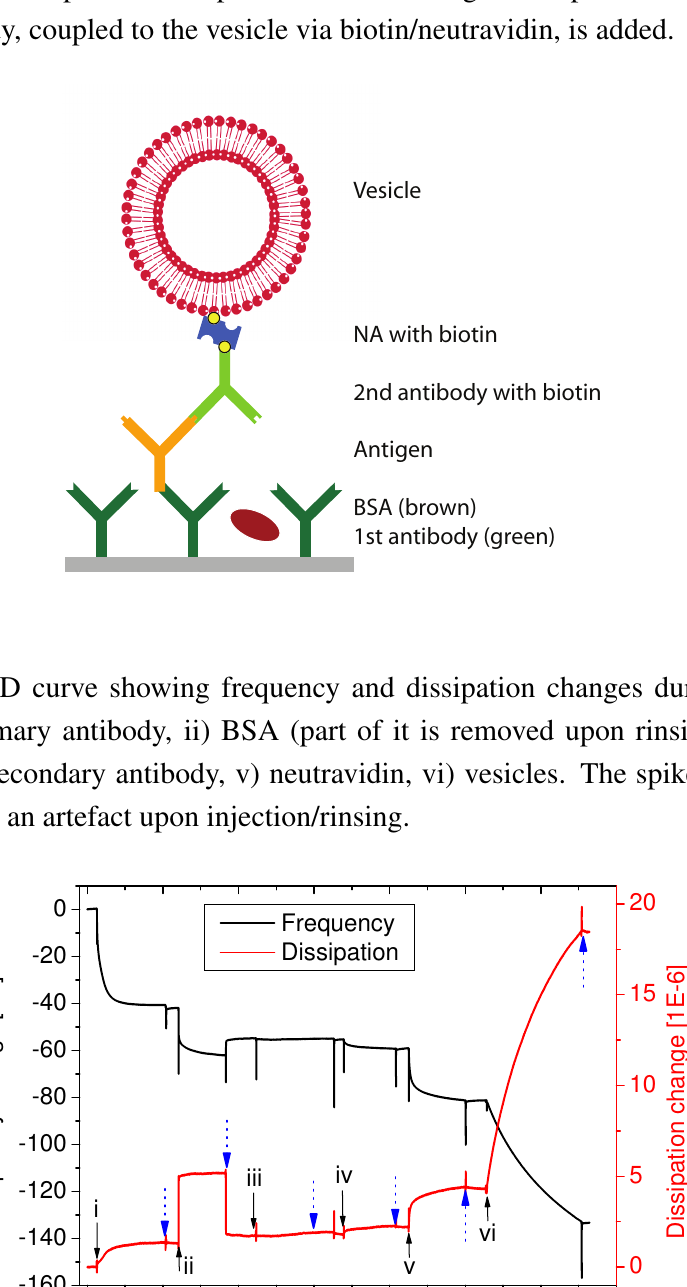
Figure 1. Scheme of our biosensor. The primary antibody is adsorbed to the substrate. BSA is added to prevent unspecific adsorption before the antigen is captured. Subsequently, the secondary antibody, coupled to the vesicle via biotin/neutravidin, is added.